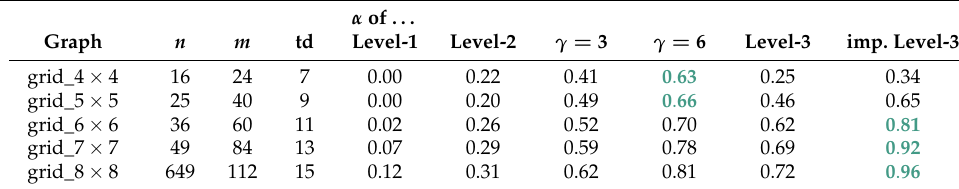
Table 4. Overview of the performance of PID ? if a single layer of the color coding sieve is used. The columns n , m , and td describe the number of vertices and edges, as well as the tree depth of the corresponding graph. The columns labeled “Level- i ” indicate that a level- i sieve is used (and non of the other layers). In this case, the level-2 sieve is used with g = 1 and the level-3 sieve in its plain version (without any improvements). Columns labeled with g = c indicate that a level-2 sieve with c colorings was used (the “random” colorings were generated with a seeded pseudo-random generator, that is, the first coloring of the g = 3 sieve is the same as the coloring of the g = 1 sieve and the first three colorings of the g = 6 sieve are the ones of the g = 3 sieve), and the column “imp. Level-3” corresponds to a level-3 sieve with the improvements discussed after Theorem 7. In each row the sieve with the best performance on this instance is highlighted.